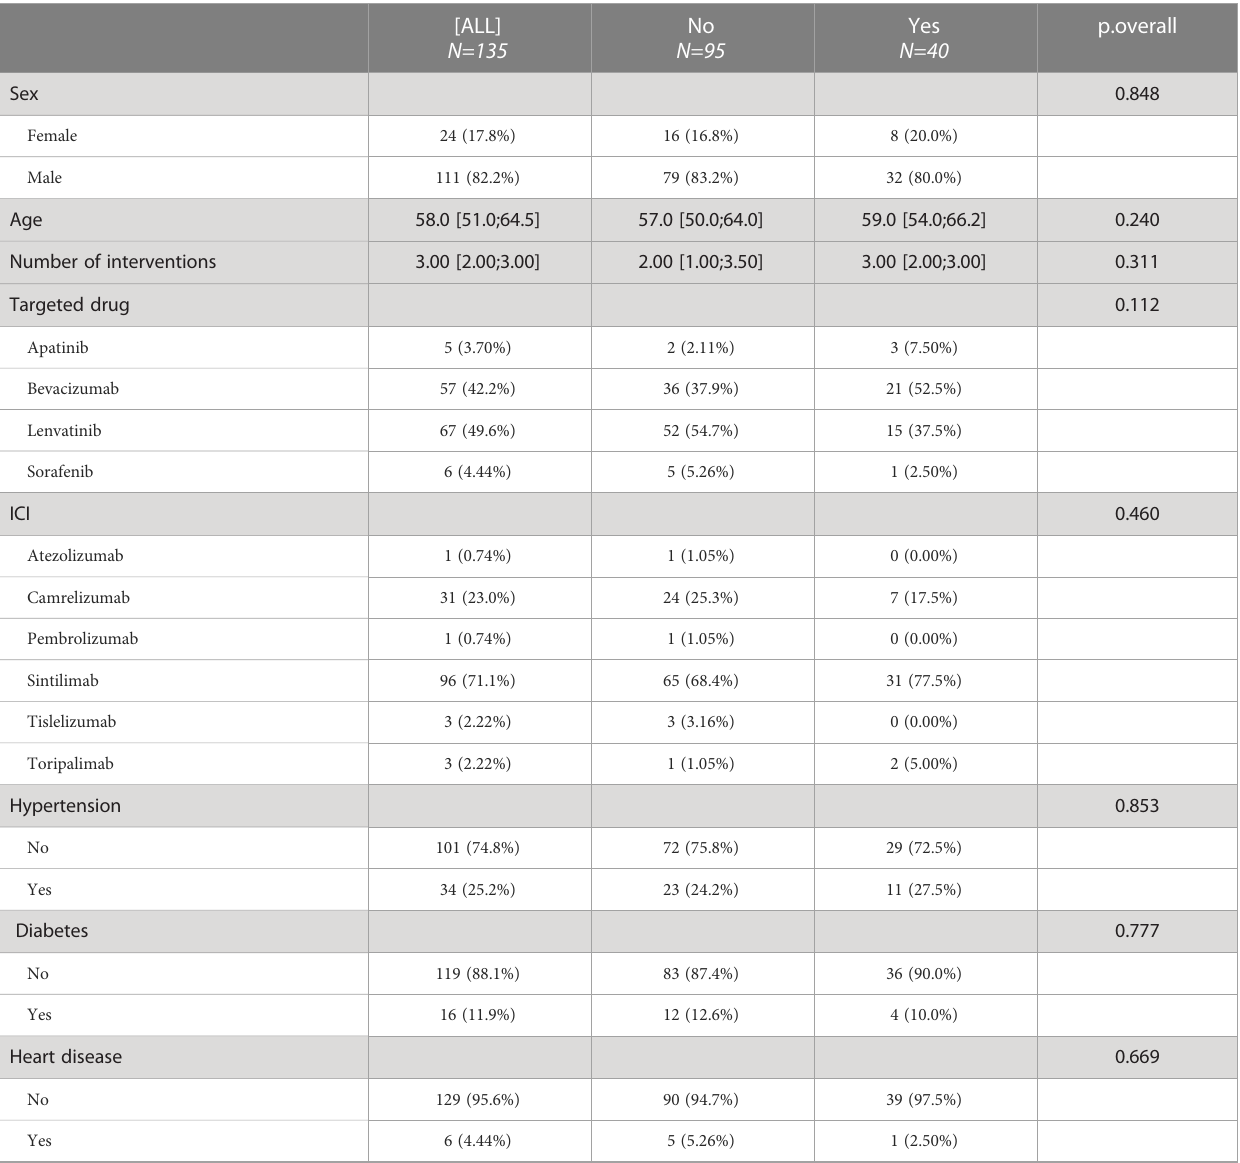
TABLE 1 Baseline information of